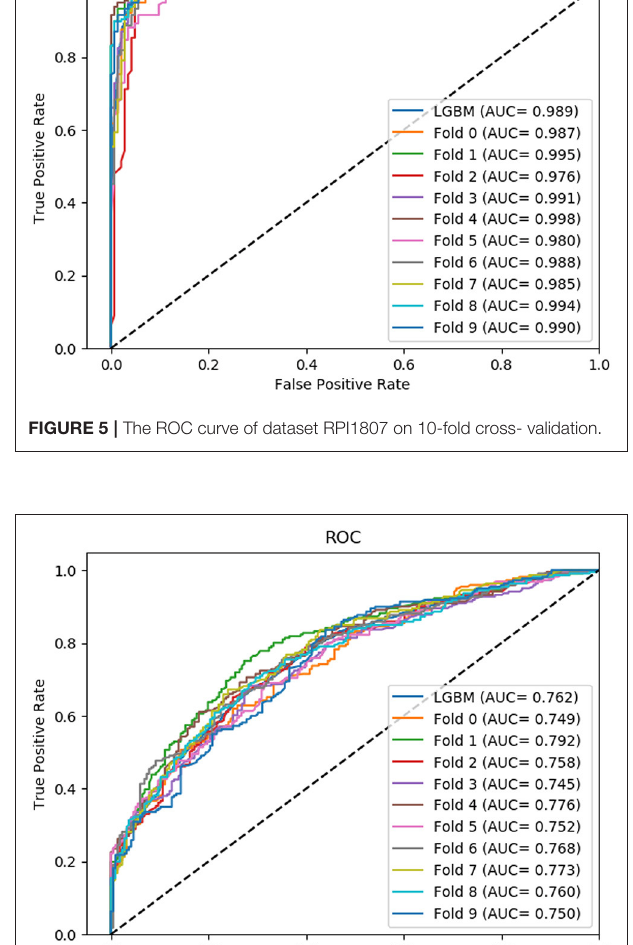
TABLE 5 | Comparison between LGBM and other methods in RPI488, RPI1807, and RPI2241. Dataset Method Accuracy (%)